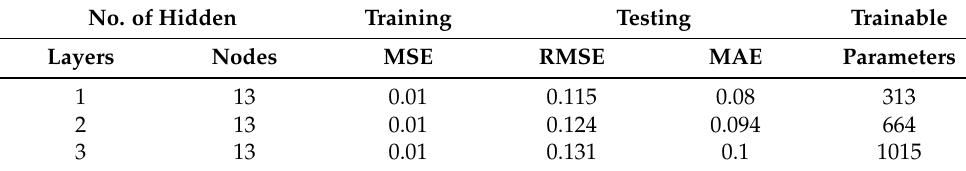
Table 5. Impact of hidden layers on the performance of the model “RHM-1”. No. of Hidden Training Testing Trainable